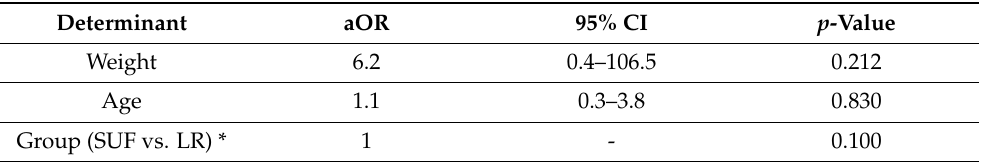
Table 4. Analysis of the determinants of methadone administration in a multivariate logistic regres- sion model.